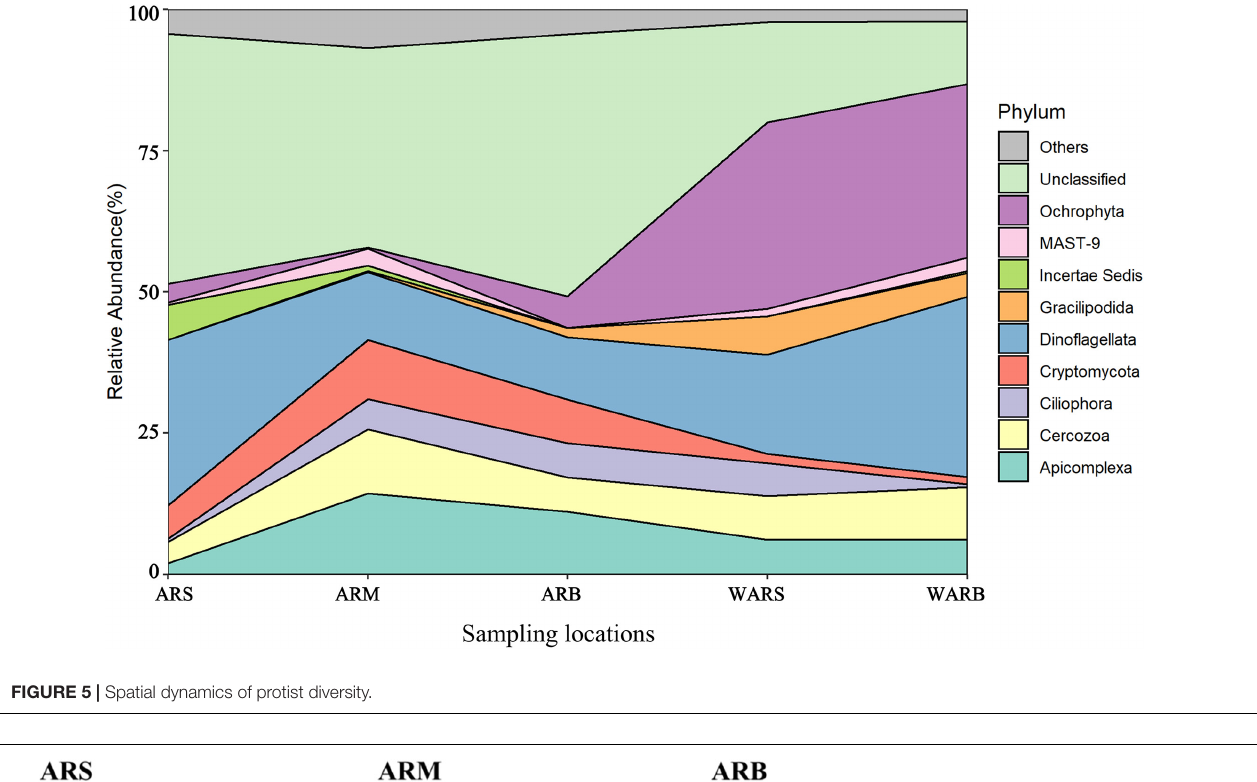
FIGURE 5 | Spatial dynamics of protist diversity.